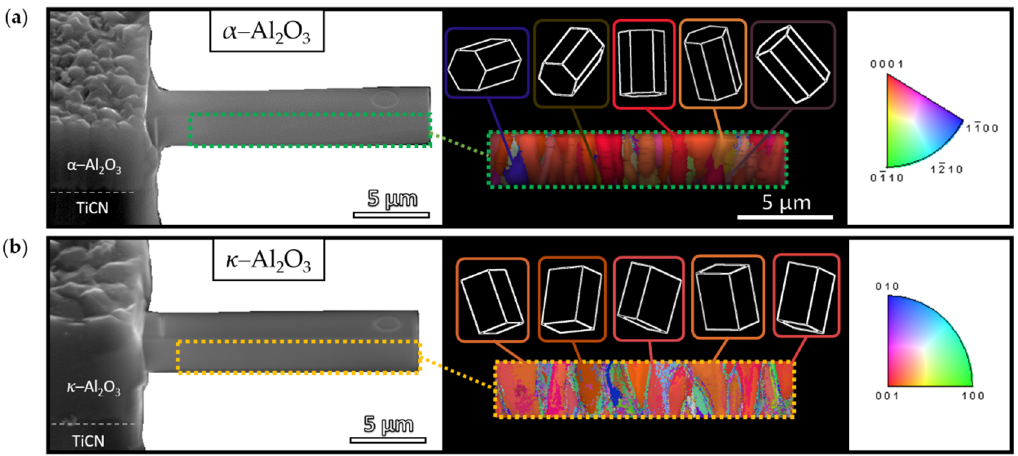
Figure 4. SEM images and IPF-Y EBSD maps of an exemplary ( a ) α – and ( b ) κ –Al 2 O 3 micro-cantilever, including the unit cells of selected grains.